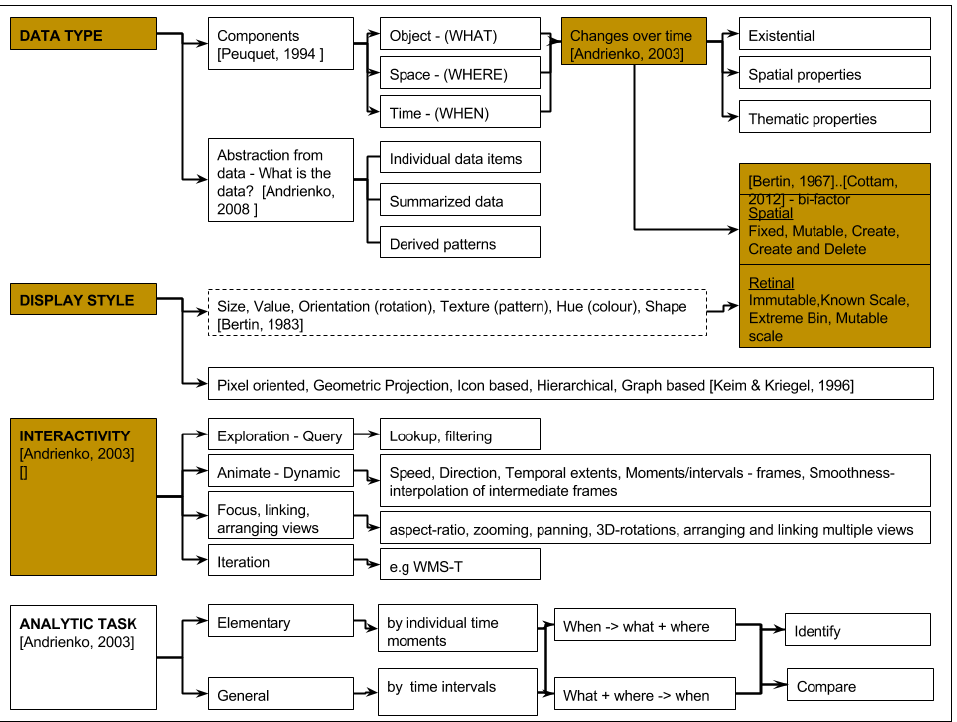
Figure 2. A classification of Geospatial Visualisation Taxonomies based on available literature (the shaded blocks represent items of interest to the